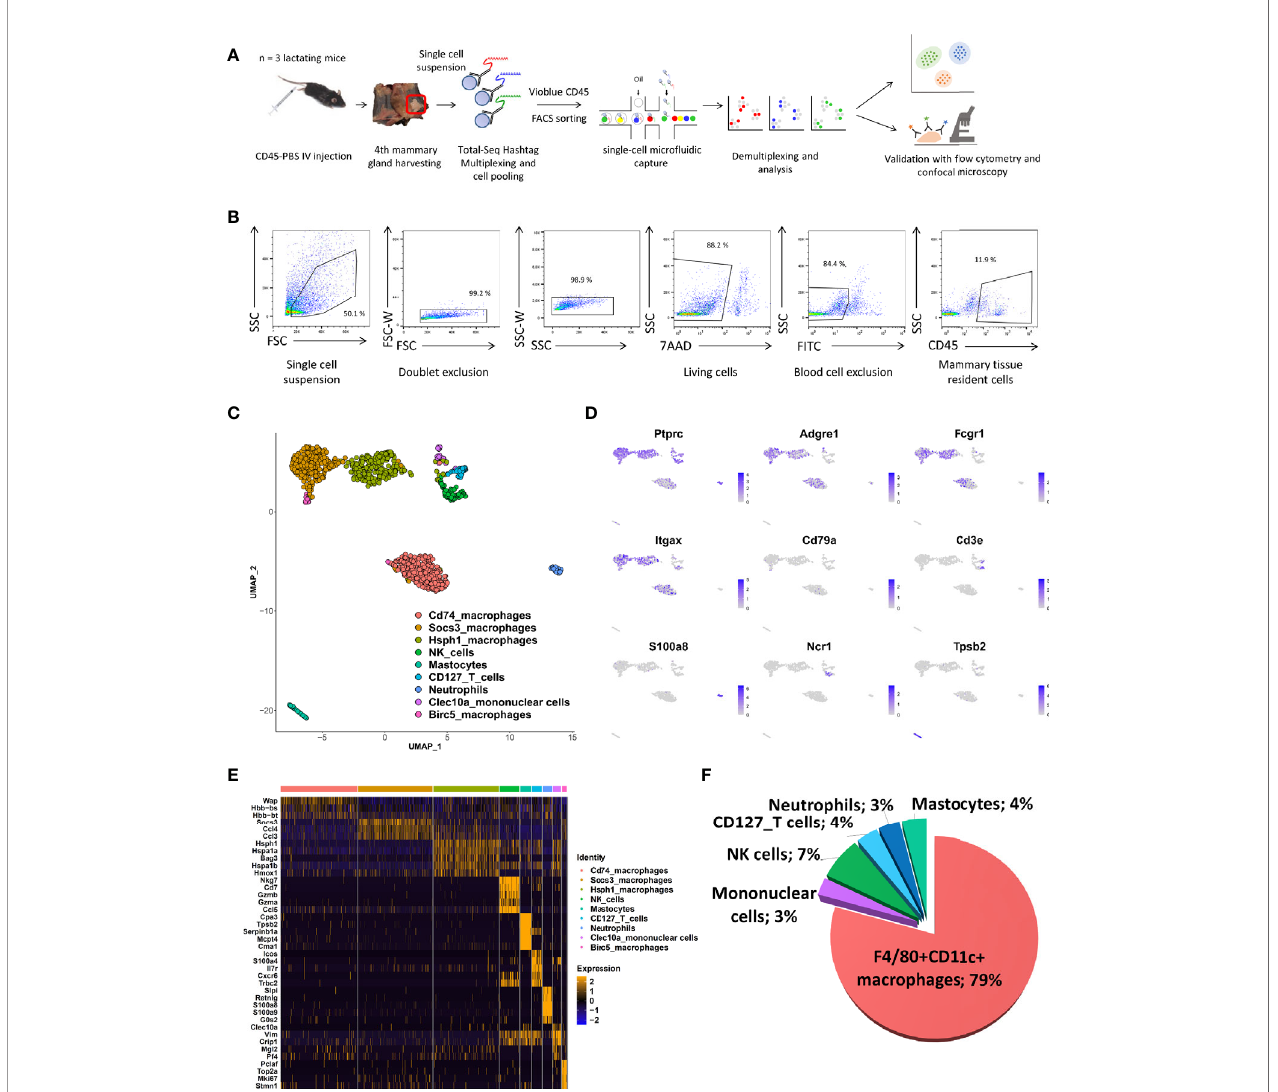
FIGURE 1 | scRNA-Seq description of immune-cell composition of the lactating mammary gland. (A) Schematic overview of the experimental pipeline used to perform the10X Chromium scRNA-Seq experiments on mammary tissue from lactating mice (n = 3). (B) Gating strategy used for FACS sorting prior to the use of single-cell Gel Beads in Emulsion (GEM). (C) UMAP plot of multiplexed CD45 pos cells isolated from the lactating mammary glands of two mice. The colors indicate clusters identi fi ed after automatic assignation. (D) Feature UMAP plots displaying the level of single-cell expression of key cell-type markers. (E) Heatmap indicating the fi ve most differentially expressed genes for each CD45 pos cell cluster. (F) Proportion of CD45 pos immune cells in the lactating mammary gland determined by scRNA-seq. The numbers indicate the percentage of each cell type among all immune CD45 pos